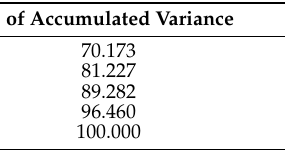
Table 6. Analysis of the dimension of the feature